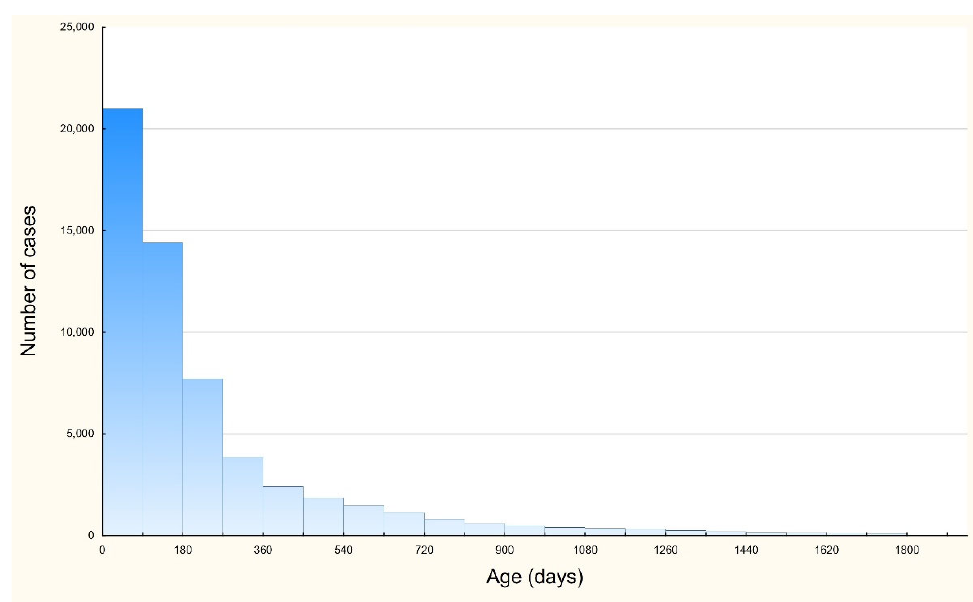
Figure 3. Number of RSV infection hospitalization cases per children age.